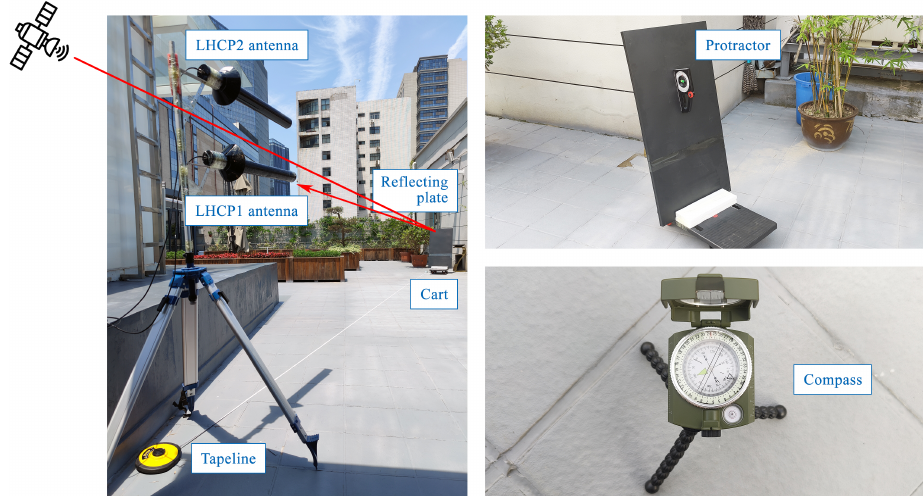
Figure 13. Experimental scenario of the additional overrange deformation